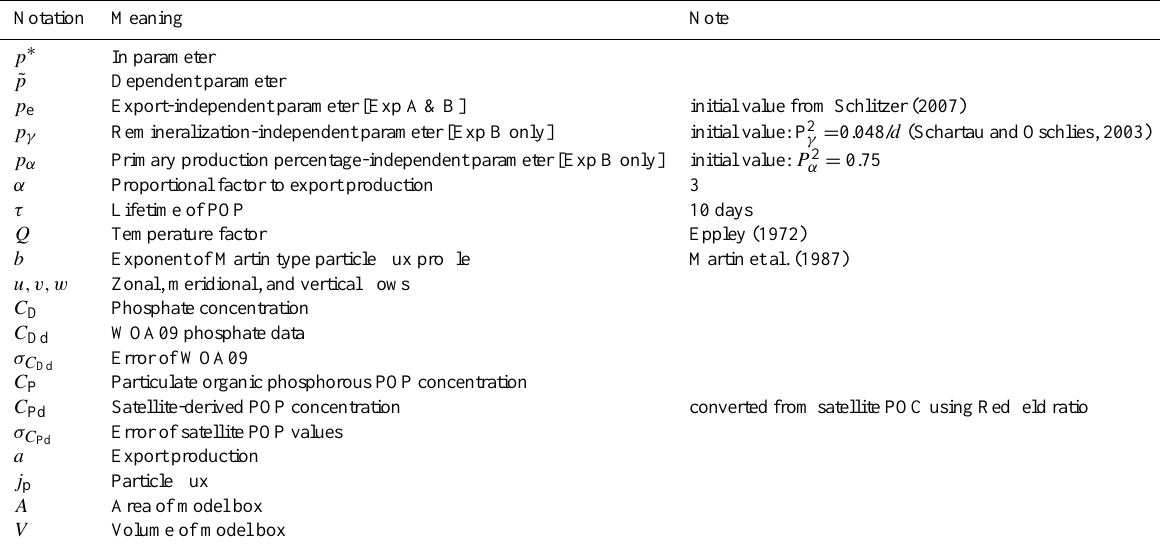
Table 1. The parameters used in the